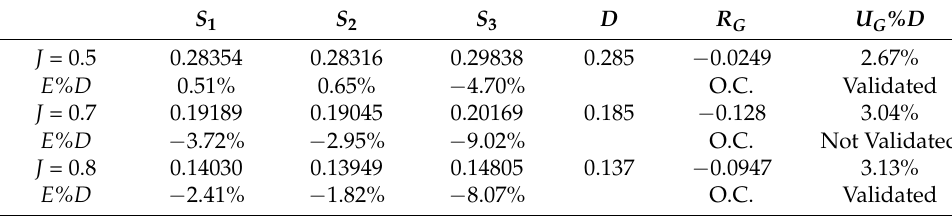
Table 6. Grid independence test result for KT .